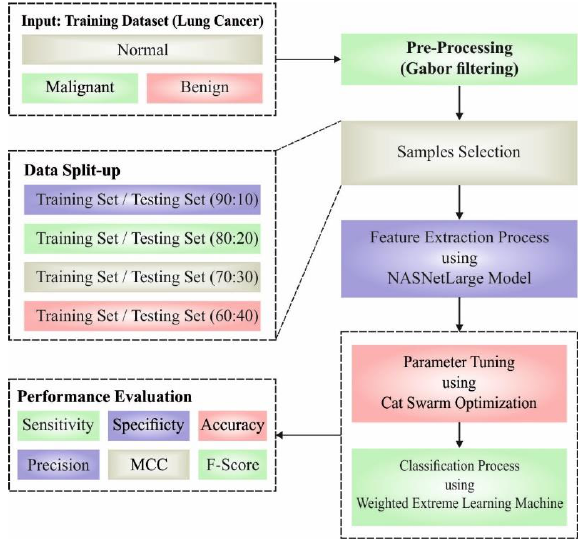
Figure 1. Overall block diagram of the CSO-CADLCC technique.